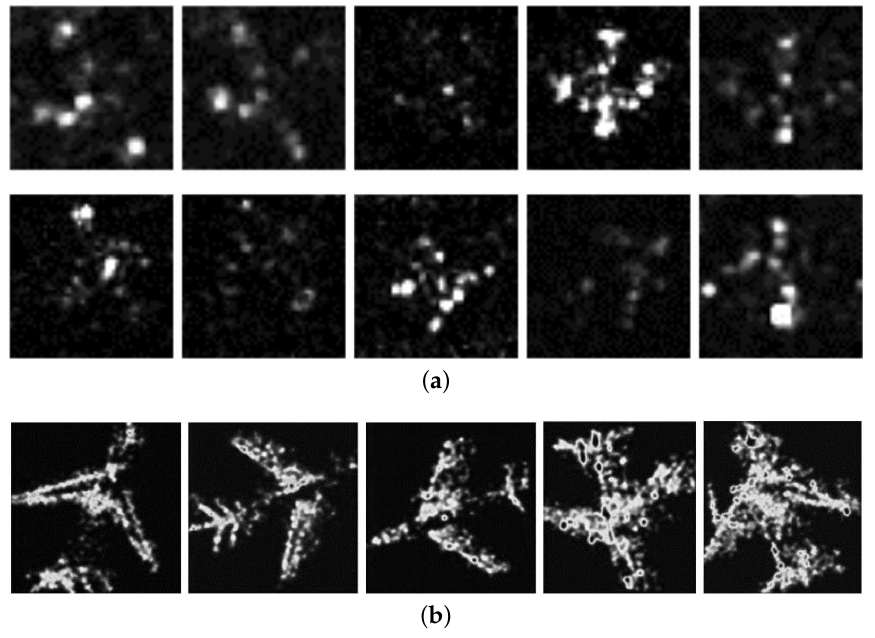
Figure 1. Examples of TerraSAR-X aircraft data slices with different resolutions: ( a ) Aircraft data slice with a resolution of 3.0 m, and ( b ) Aircraft data slice with a resolution of 1.0